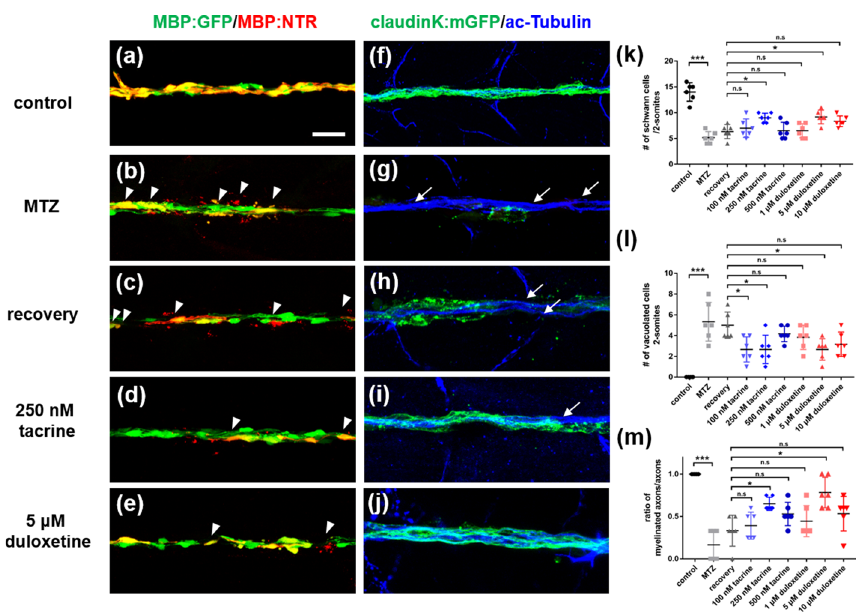
Figure 3. Tacrine and duloxetine enhance regeneration of Schwann cells in posterior lateral line axons after Schwann cell ablation. All images are lateral views of the posterior lateral line of ( a–e ) Tg(mbpa:gal4- vp16;uas:egfp;uas:NTR-mCherry), ( f–j ) Tg(claudinK:gal4-vp16;uas:megfp;uas:NTR-mCherry) larvae at 8 days post-fertilization (dpf). Anterior to the left and dorsal to the top. ( a–e ) GFP fluorescence indicates MBP- positive Schwann cells and red fluorescence indicates NTR + Schwann cells or vacuolated Schwann cells. Arrowheads indicate vacuolated cells. ( f–j ) GFP fluorescence indicates ClaudinK-positive myelin sheaths and blue fluorescence indicates acetylated tubulin-positive PLL axons. Arrows indicate demyelinated axons without GFP + myelin sheaths. ( k ) Quantification of the number of Schwann cells per 2-somite area. Control: 14 ± 1.79, MTZ: 5.16 ± 1.17, recovery: 6.33 ± 0.37, 100 nM tacrine: 7 ± 1.79, 250 nM tacrine: 9 ± 0.89, 500 nM tacrine: 6.5 ± 1.64, 1 μM duloxetine: 6.5 ± 1.33, 5 μM duloxetine: 9.17 ± 0.32, 10 μM duloxetine: 8.33 ± 1.03. ( l ) Quantification of the number of vacuolated cells per 2-somite area. Control: 0, MTZ: 5.33 ± 1.86, recovery: 5 ± 1.26, 100 nM tacrine: 2.67 ± 1.21, 250 nM tacrine: 2.67 ± 1.7, 500 nM tacrine: 4.17 ± 0.75, 1 μM duloxetine: 3.83 ± 1.17, 5 μM duloxetine: 2.27 ± 1.03, 10 μM duloxetine: 3.17 ± 1.17. ( m ) Ratio of the number of myelinated axons is indicated per total number of axons. Control: 1, MTZ: 0.165 ± 0.18, recovery: 0.33 ± 0.18, 100 nM tacrine: 0.39 ± 0.16, 250 nM tacrine: 0.65 ± 0.08, 500 nM tacrine: 0.53 ± 0.14, 1 μM duloxetine: 0.44 ± 0.18, 5 μM duloxetine: 0.78 ± 0.18, 10 μM duloxetine: 0.53 ± 0.2. n = 6 per group. The experiment was independently repeated three times. *** p < 0.001; ** p < 0.01; * p < 0.05; n.s., not significant. Scale bar, 25